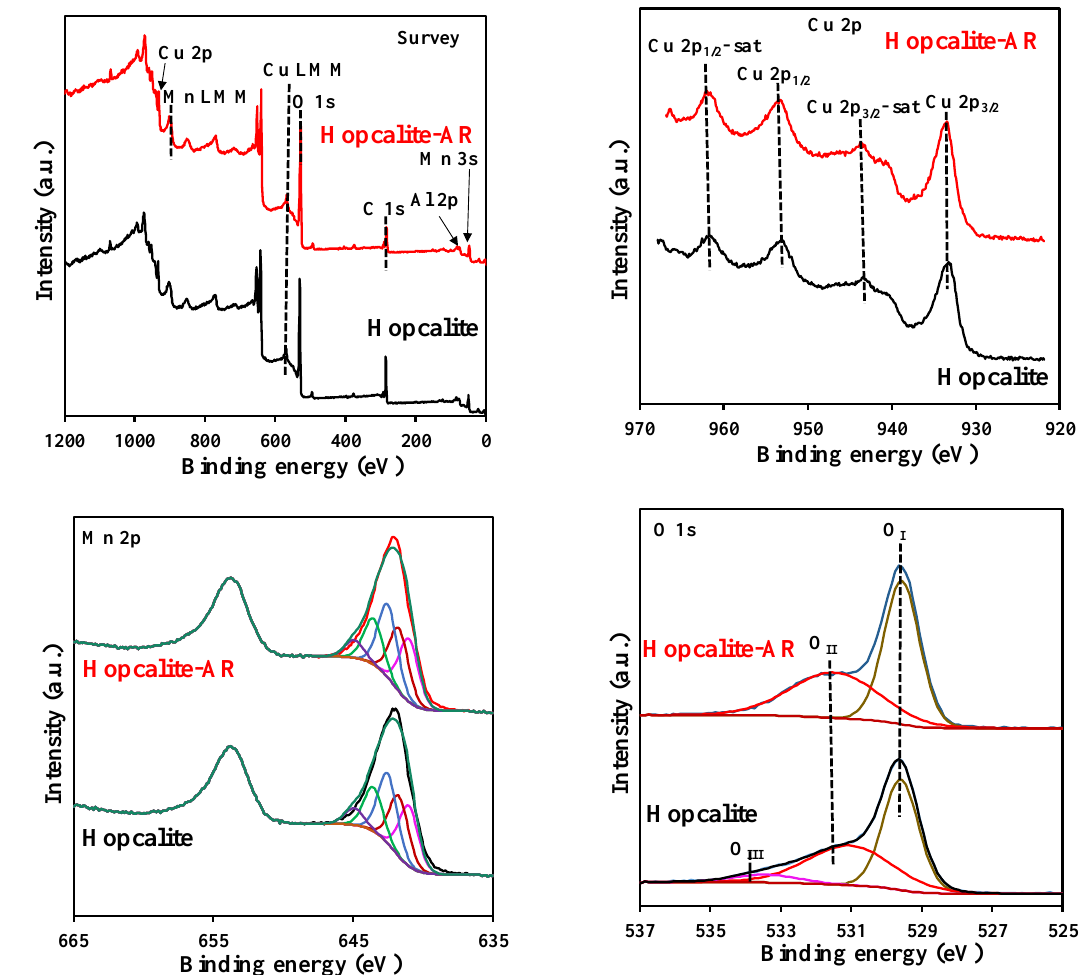
Figure 7. XPS survey spectra and high resolution Cu 2p, Mn 2p, and O 1s spectra of Hopcalite and Hopcalite-AR. The H 2 -TPR profiles of the fresh Hopcalite and the Hopcalite after reaction (thus after 15 NTP exposures) shown in Figure 8 are complex [24] and quite similar except for the absence of the reduction peak at 149 ◦ C for the Hopcalite after reaction. The absence of the peak at 149 ◦ C for Hopcalite after reaction may be due to the reduction of CuO x into Cu (0) [31]. On the other hand, in comparison to the fresh catalyst, in which XPS and H 2 -TPR reveal the presence of the Cu 2+ , this latter species is absent in the H 2 TPR profile of the used catalyst. However, the H 2 consumption values are similar for the pristine and used Hopcalite (11 ± 2 mmol · g − 1 , c.f. Table 5). Moreover, the absence of the peak (at 149 ◦ C) which corresponds to Cu 2+ in H 2 TPR does not influence the performance of Hopcalite in APC abatement of toluene.